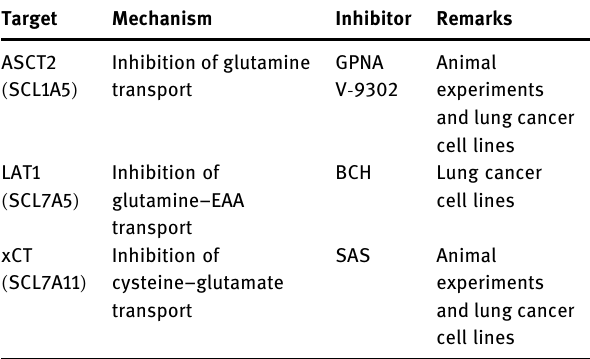
Table 2: Di ff erent inhibitors of